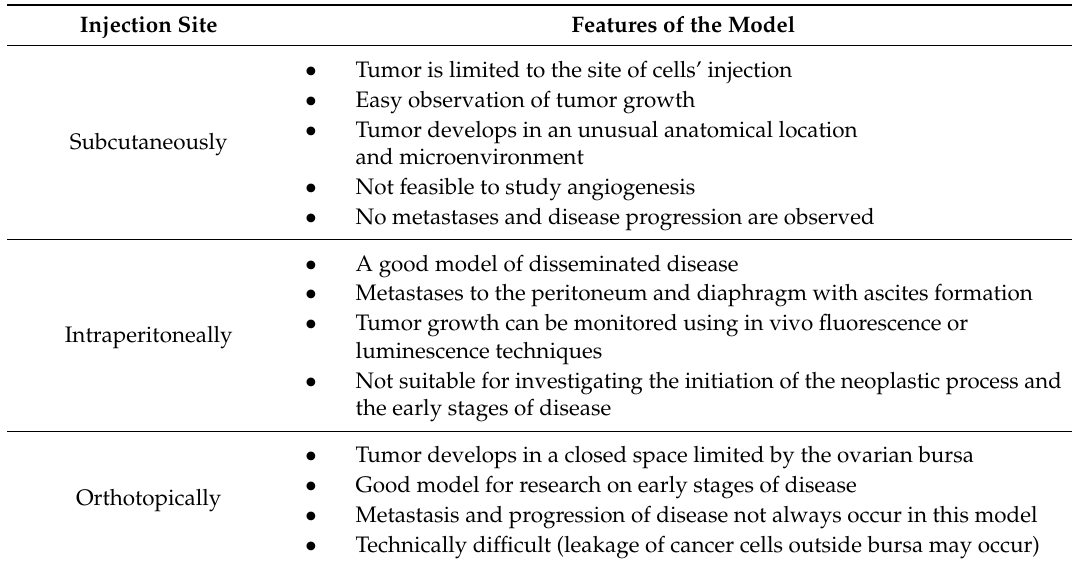
Table 2. Features of xenograft models depending on the site of cancer cells